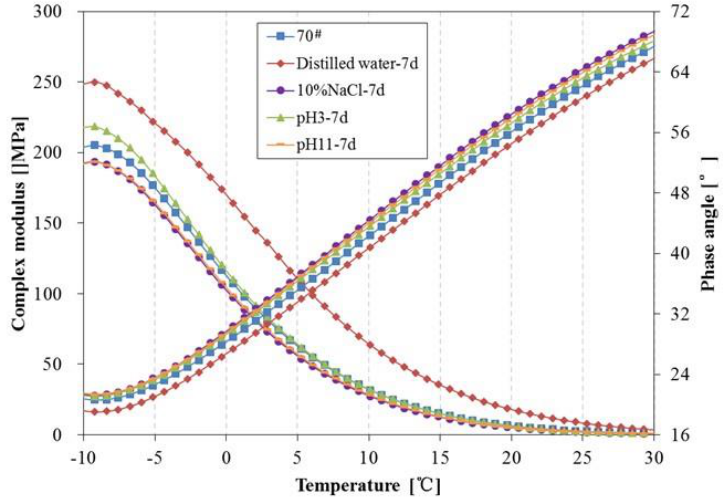
Figure 8. Complex modulus and phase angle of 70 # asphalt before and after 7 days immersion.